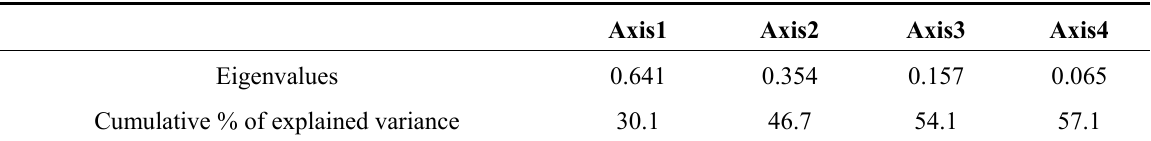
Table 5. Detrended Correspondence Analysis (DCA) of the EFTs with the Köppen climate zones.